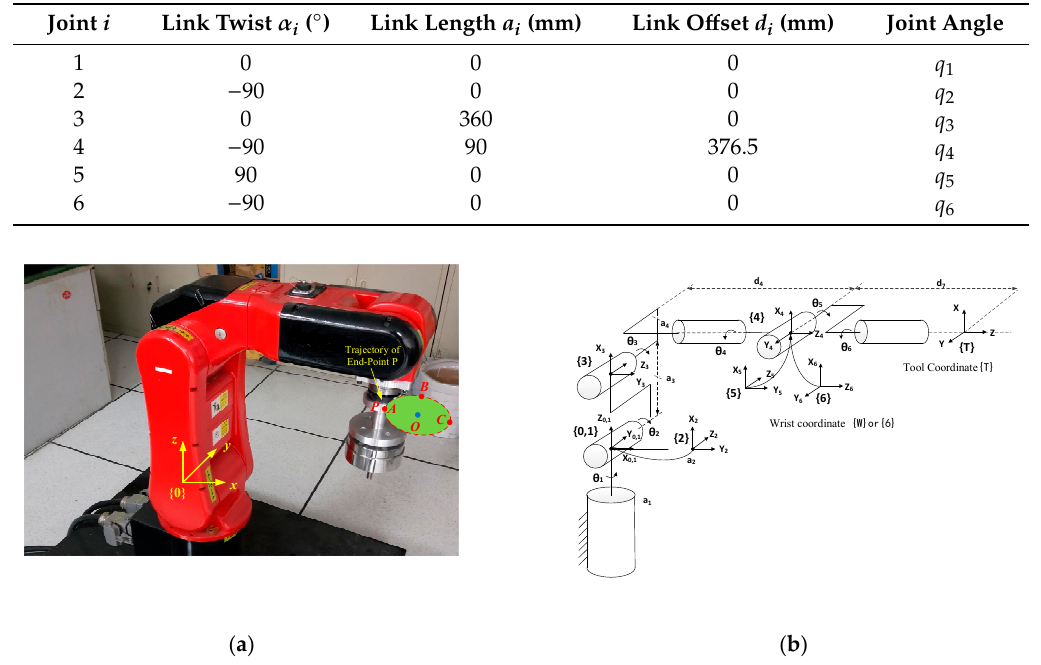
Figure 7. Experimental robot. ( a ) Robot end-point end P trajectory; ( b ) coordinate system.